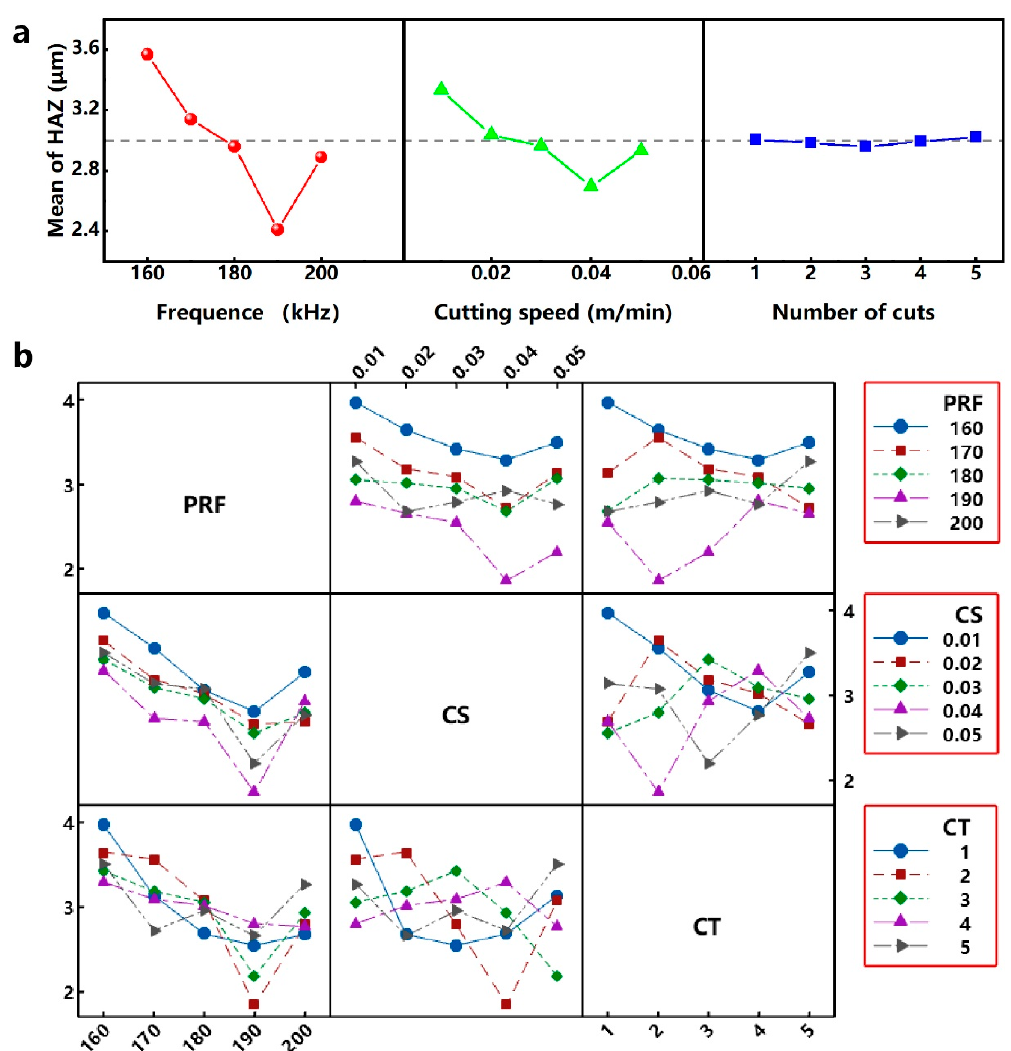
Figure 6. ( a ) Effect of process parameters on size of HAZ. ( b ) Interactions between each parameter parameter for size of HAZ.